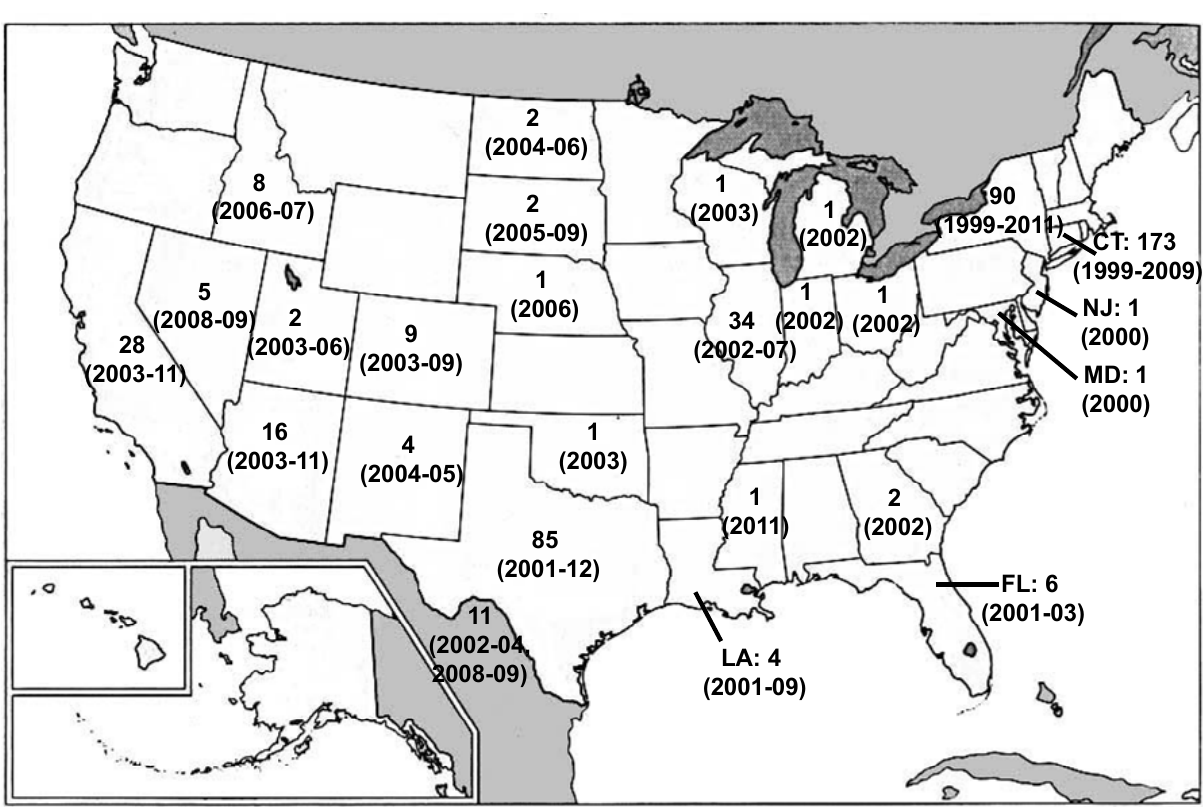
Figure 5. Map of the United States showing genomic sequences available by state and